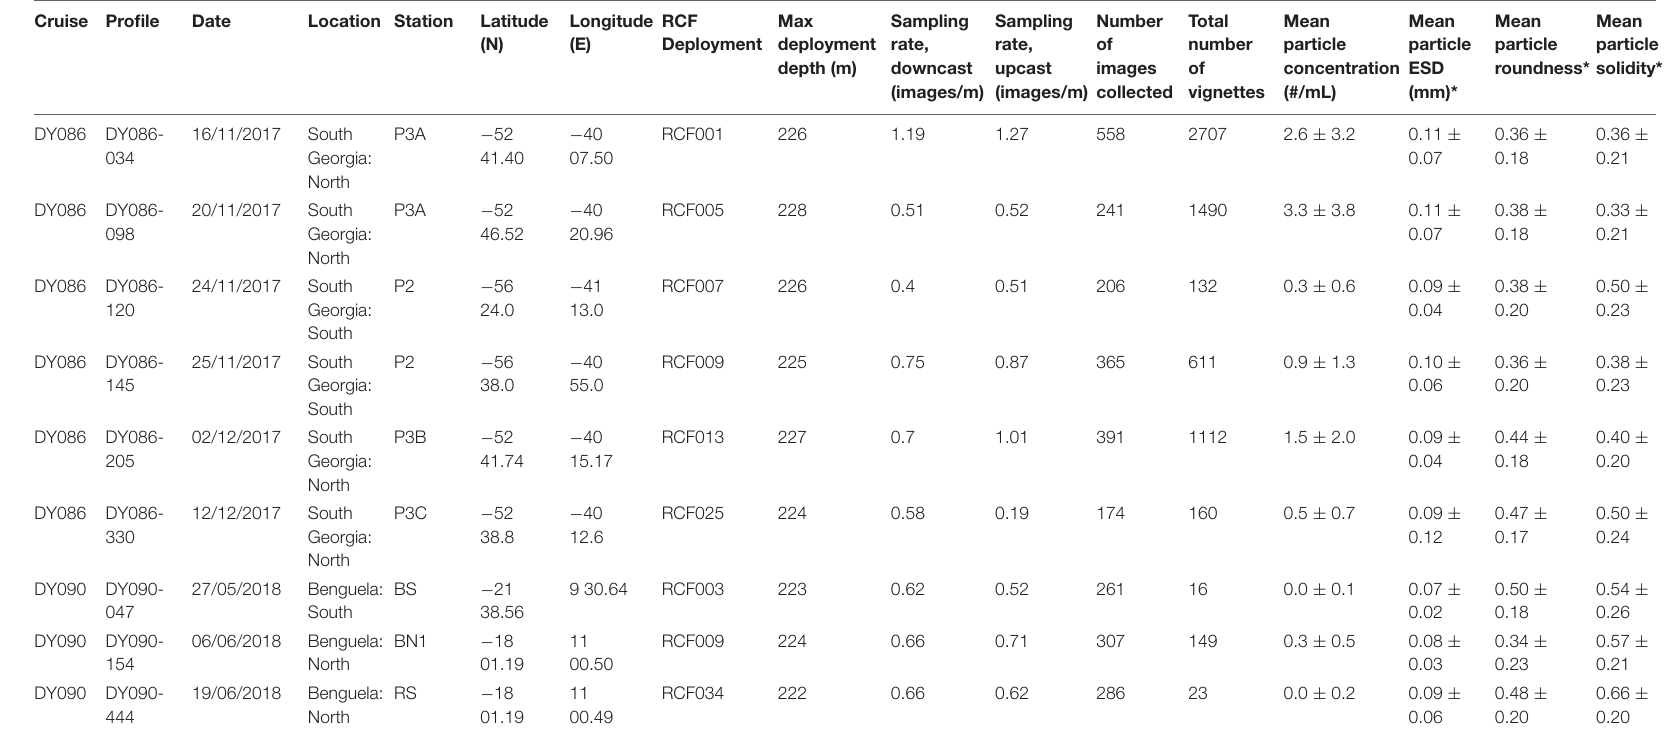
TABLE 4 | Deployment details and simple particle profile